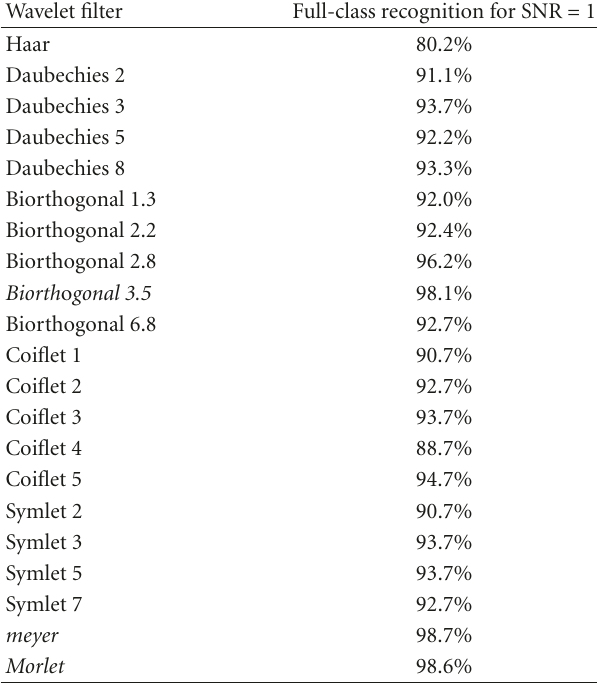
Table 9: Algorithm performance and wavelet family.